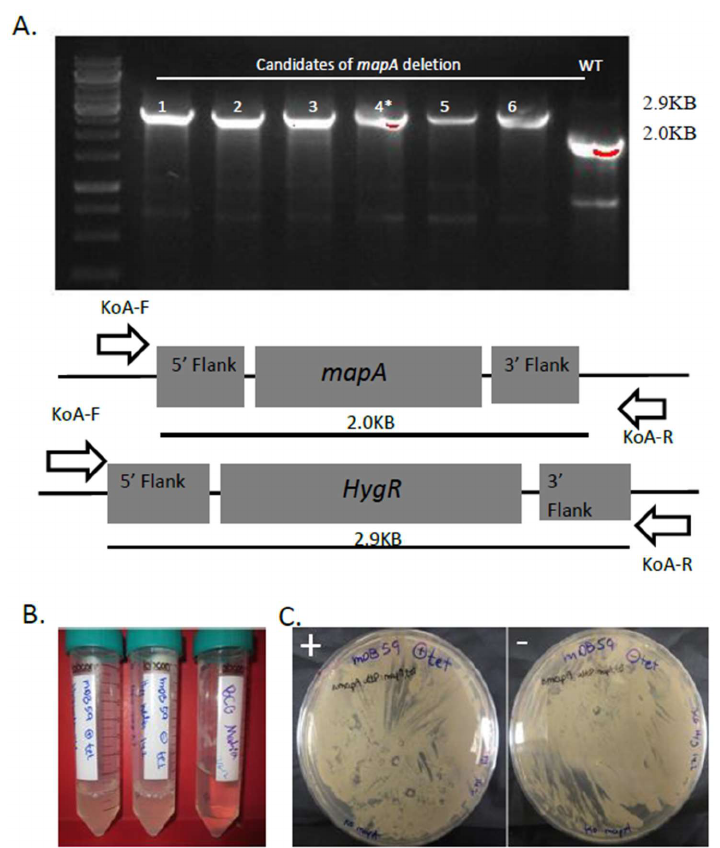
Figure 1. ( A ) Creation and confirmation of a mapA deletion mutant. After infection with phDB20, six hygromycin resistant colonies were analyzed by PCR. All six produced a pattern consistent with mapA deletion and colony four was named mDB59. ( B , C ) mDB59 is not dependent on ATc for growth. ( B ) mDB59 was grown with (leftmost tube) and without (middle tube) ATc (inducing the expression of mapA ) in liquid. The rightmost tube is clear 7H9 media. ( C ) Left–with ATc, Right–no ATc. No difference in growth is apparent.